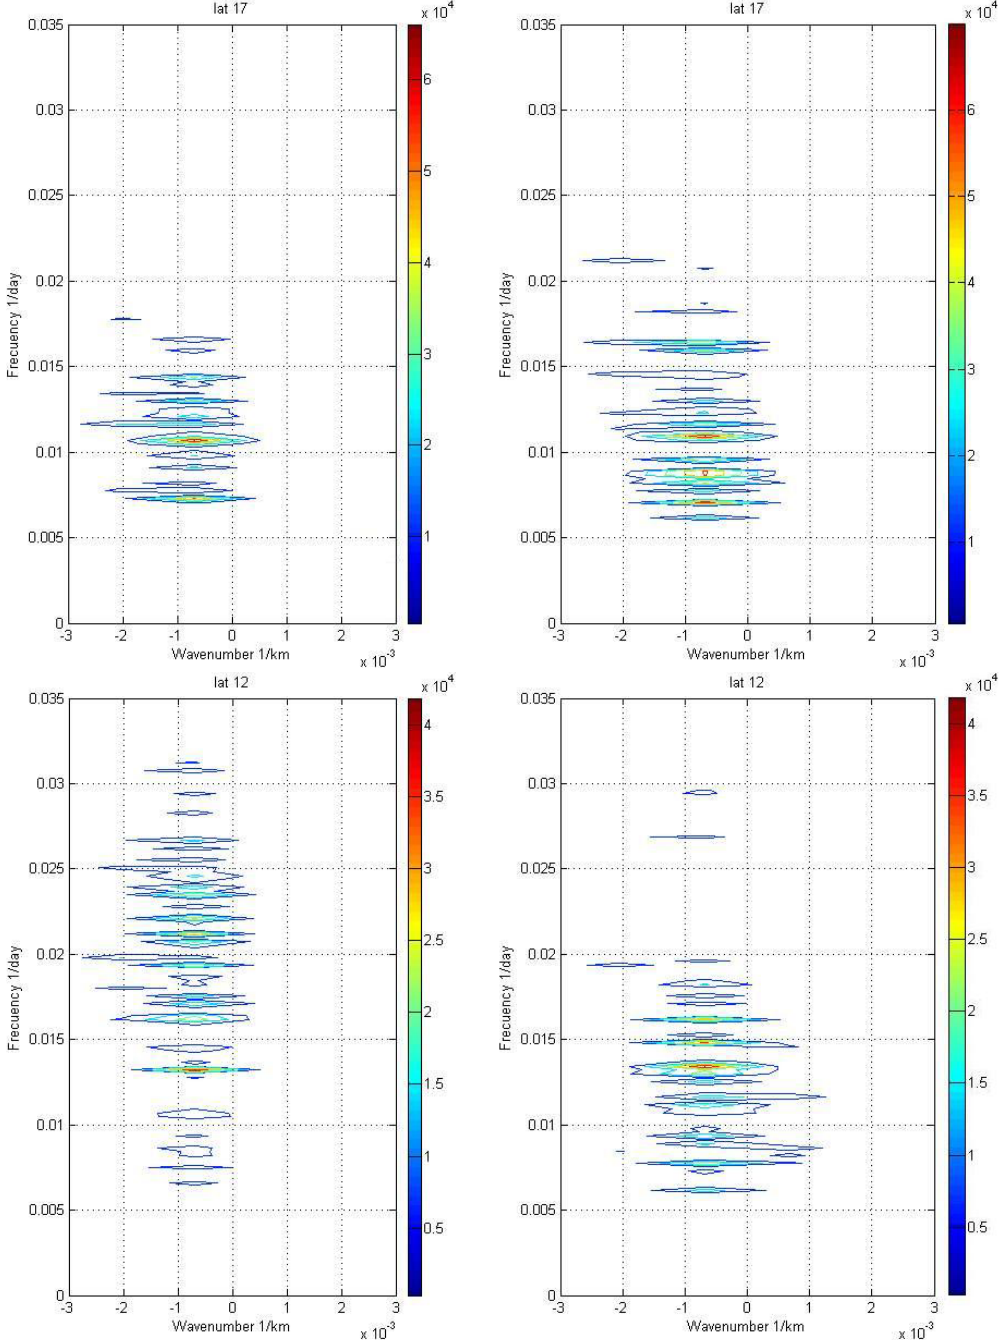
Fig. 8. Fast Fourier transform at 17 ◦ N (top) and at 12 ◦ N (bottom) before (left) and after (right) the LA.